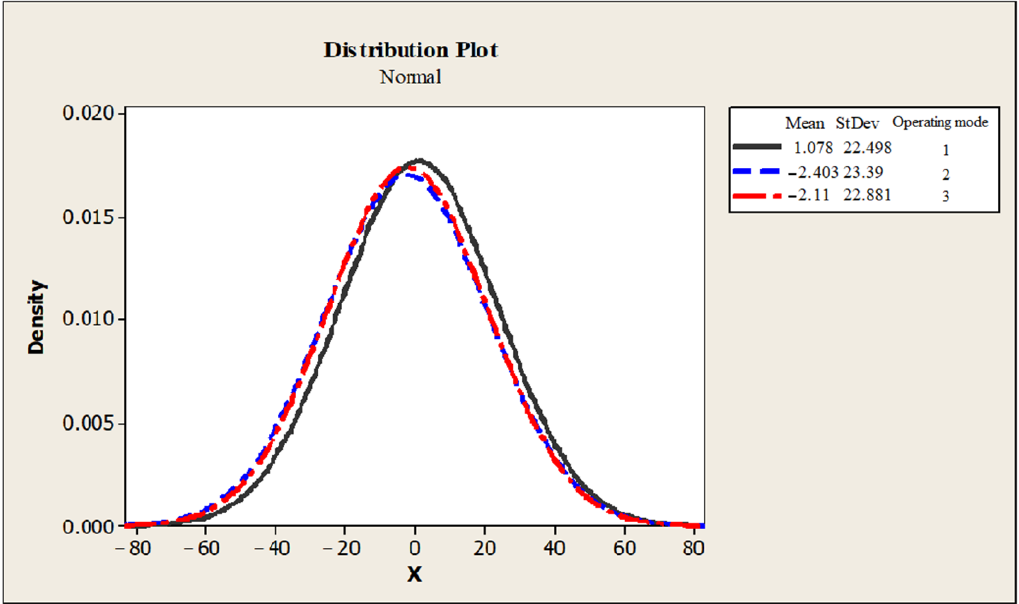
Figure 10. Power residual distributions for all operating modes using ANN model II.